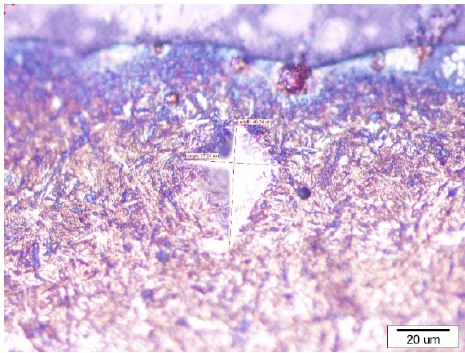
Figure 13. Display of measurement positions of micro hardness tests on the tooth.